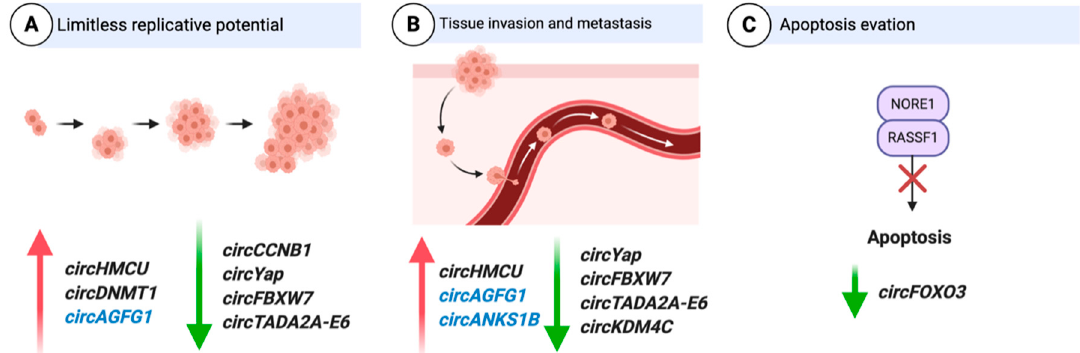
Figure 4. CircRNAs associated with hallmarks of breast cancer . Red arrows depict upregulation and green arrows depict downregulation. CircRNAs in blue are triple negative breast cancer (TNBC) specific. Adapted from “The Hallmarks of Cancer (Classical),” by BioRender.com (2020). Retrieved from https://app.biorender.com/biorender-templates .